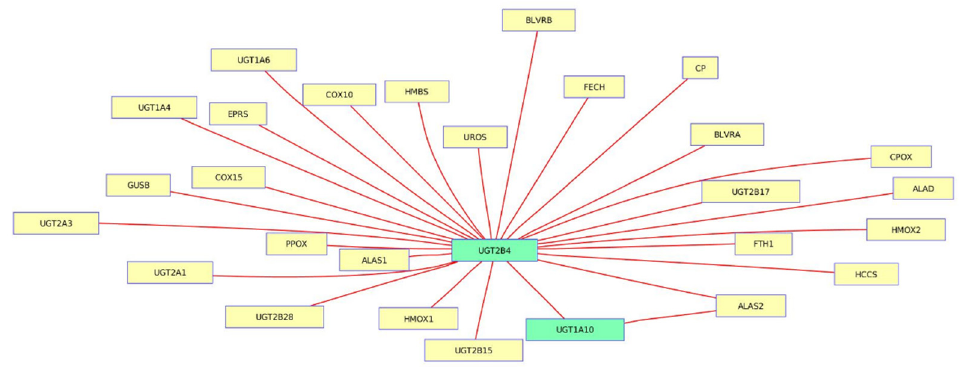
Figure 5. Gene–gene interactions in the PorChM pathway induced by trichostatin A. The red lines represent inhibition. represent inhibition.